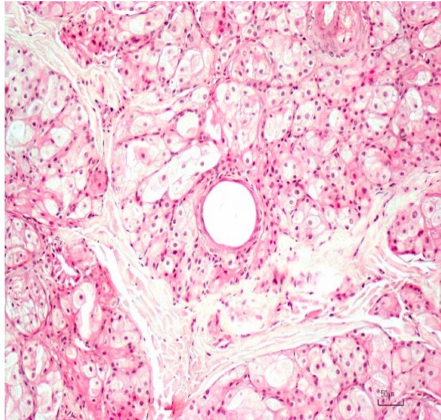
Figure 5. Enlarged sebaceous lobules oriented around a small dilated duct lined by squamous keratinizing epithelium characterized the sebaceous gland hyperplasia. H&E. Bar 50 µ